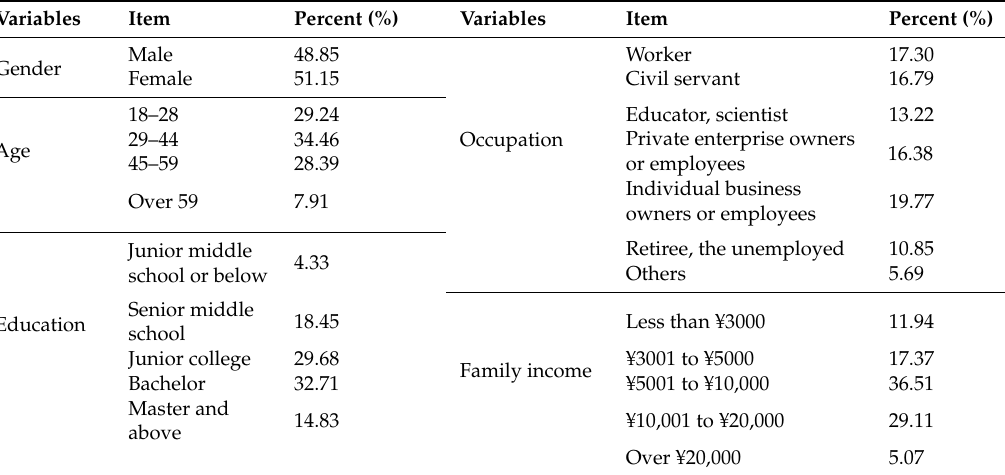
Table 2. Distribution of social-demographic characteristics